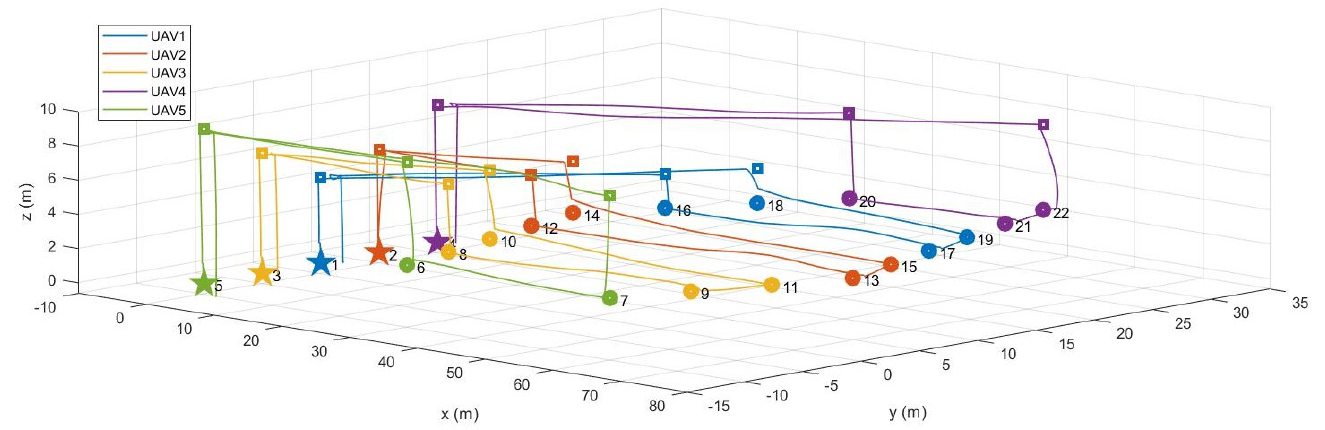
Figure 10. MATLAB and gazebo cosimulation